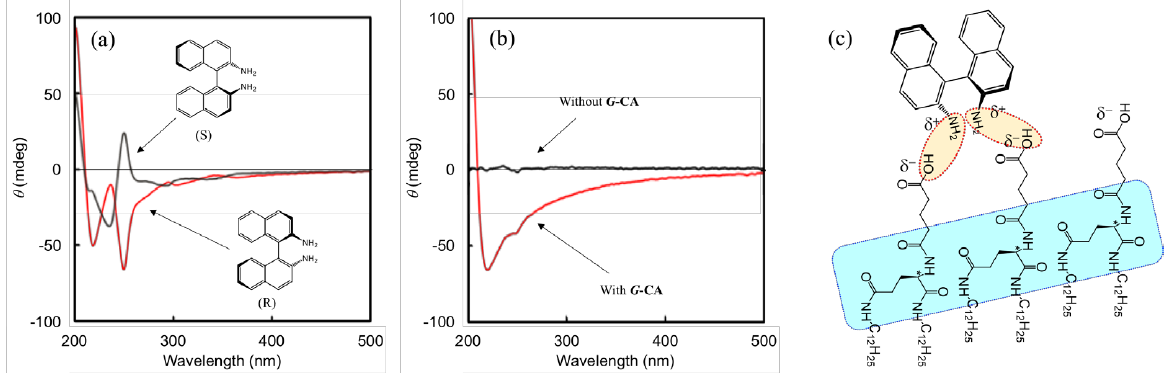
Figure 5. ( a ) CD and ( b ) different CD spectra for G -CA systems containing chiral BD. Solvent: 95:5 (v/v) methylcy- clohexane:THF. Concentrations: G -CA, 0.75 mM; dyes, 0.05 mM; TEA, 0.5 mM. Temperature: 0 ◦ C. ( c ) Illustrating the R-BD-on- G -CA (guest-host) interaction. The blue parts show that hydrogen bonding induces secondary chirality with a highly ordered state. The orange parts show multiple interactions of a guest molecule with the highly ordered